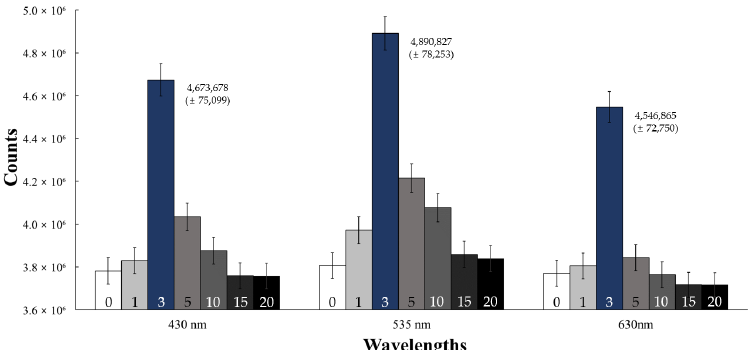
Figure 5. Measurements of transmitted light intensities with the number of RGO coatings according to the three kinds of wavelengths of emission lights (average values and standard deviations are listed).